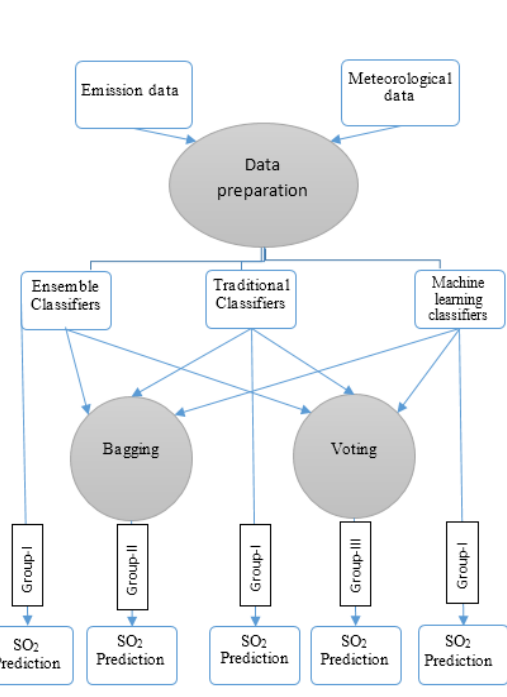
Fig 2: Experiment setting